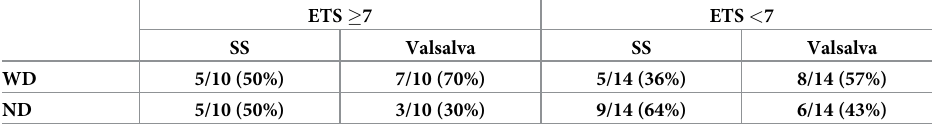
Table 3. Comparison between the two diagnostic tools in positive and negative ETD. ETS � 7 ETS < 7 SS Valsalva SS Valsalva WD 5/10 (50%) 7/10 (70%) 5/14 (36%) 8/14 (57%) ND 5/10 (50%) 3/10 (30%) 9/14 (64%) 6/14 (43%) ETS = Eustachian tube score; WD = well Defined; ND: not defined; SS = steady